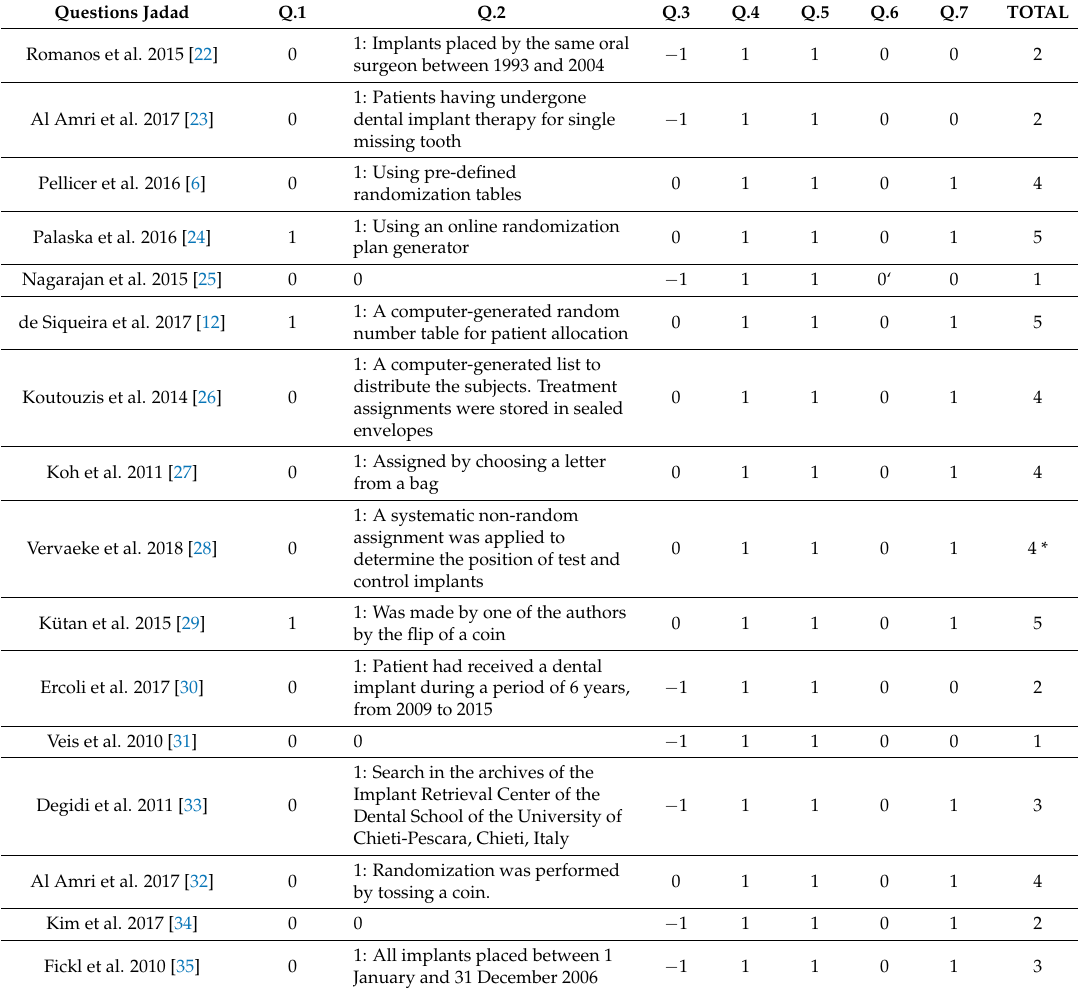
Table 1. Jadad score in studies